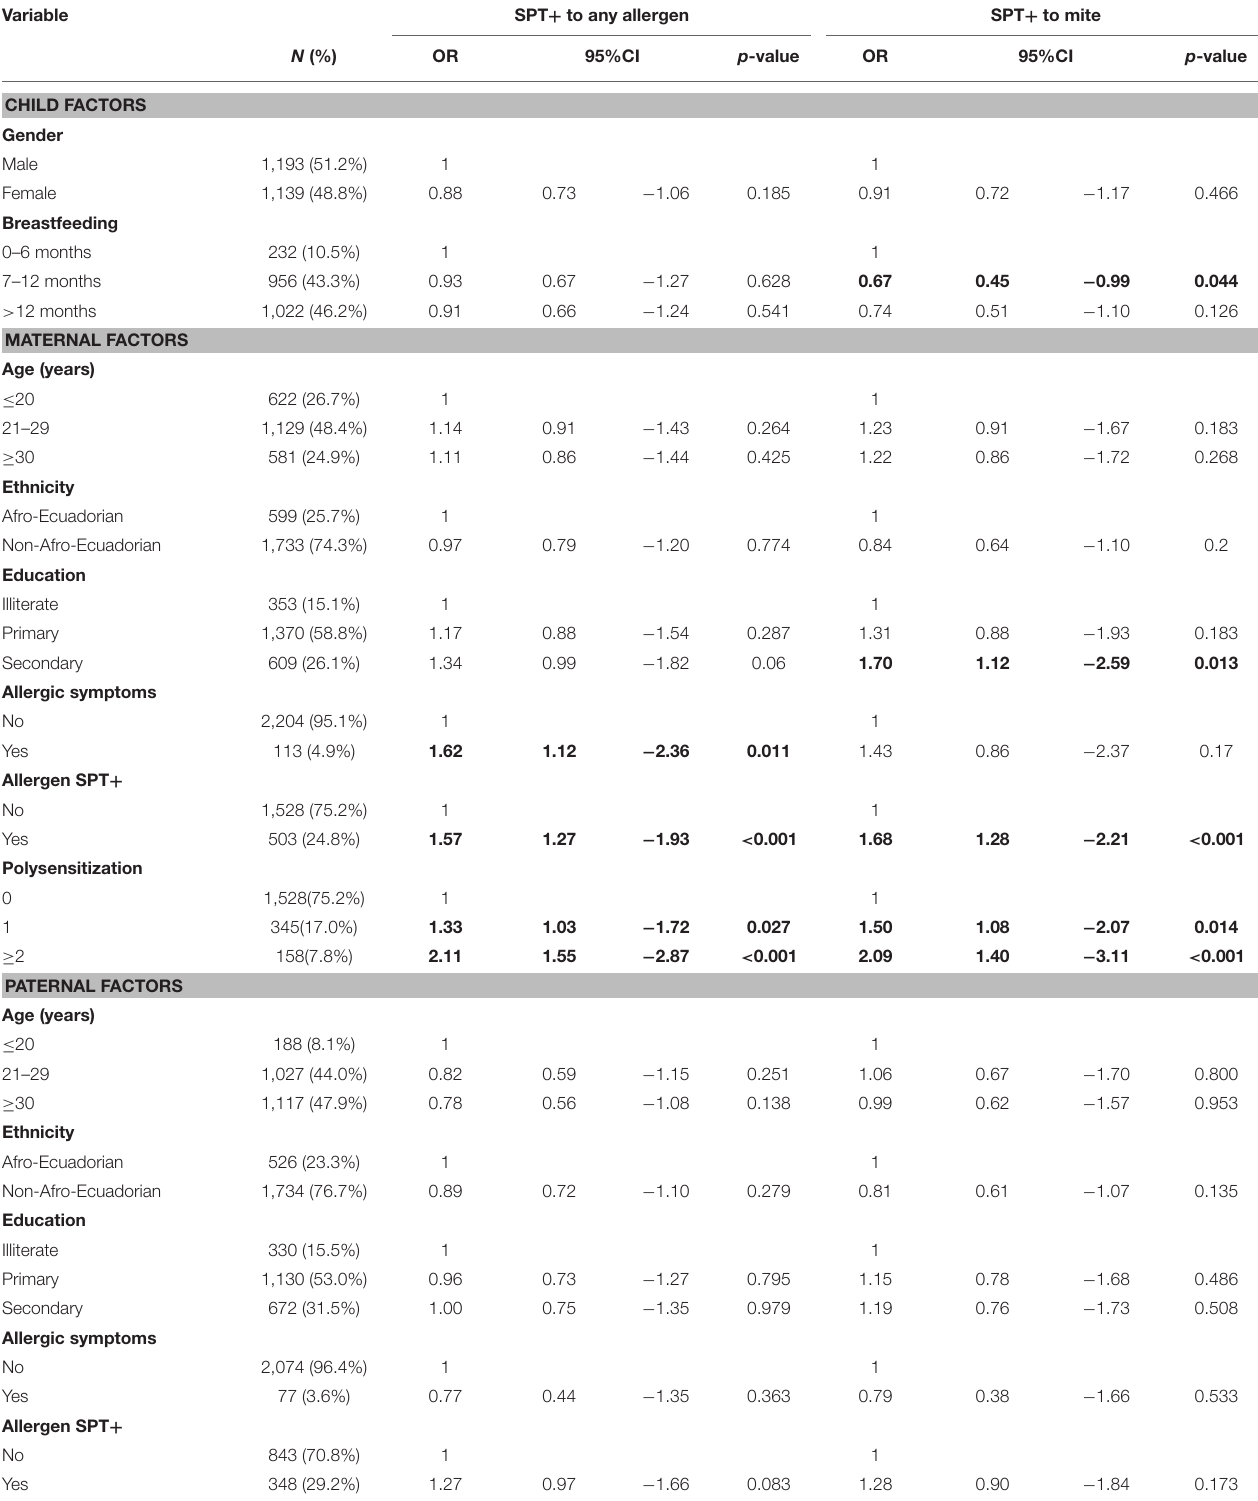
TABLE 1 | Minimally age-adjusted associations between risk of allergen skin prick test positivity (SPT + ) to any and to mite allergens during first 8 years of life and child, parental, household, and hygiene factors.